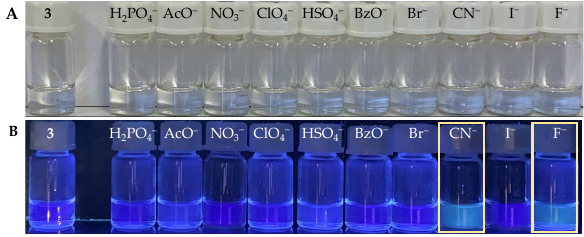
Figure 2. Normalized absorption and emission spectra of compound 3 , in ACN.